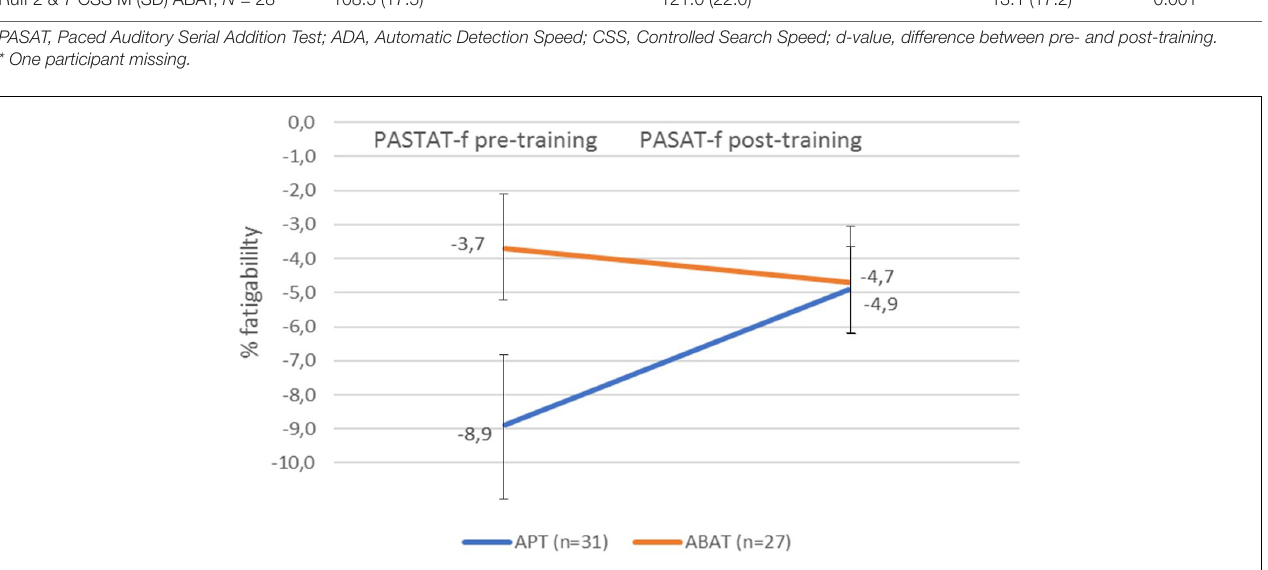
FIGURE 2 | Fatigability pre-training and post-training as measured by the PASAT-f for both treatment groups. Fatigability values represent the percentage of correct answers in the first quintile of the PASAT subtracted from the number of correct answers in the last quintile of the PASAT. A negative value indicates fatigability. The error bars represent SD. APT, Attention Process Training; ABAT, Activity-Based Attention Training; PASAT-f, Paced Auditory Serial Addition Test